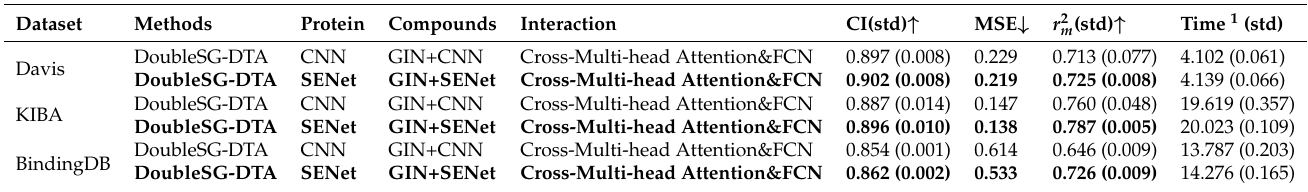
Figure 3. Impact of the layers of the graph isomorphism network on the performance of DoubleSG- DTA. Table 6. Investigating the contributions of SENet on Davis, KIBA, and BindingDB datasets.